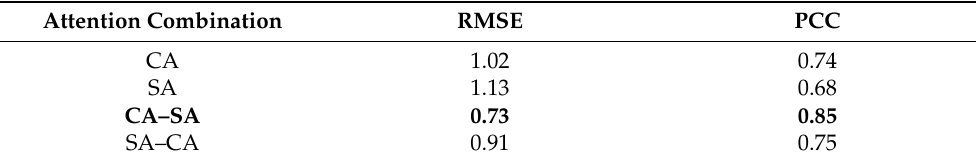
Table 2. Comparison of different attention modules with their composite structures. Attention